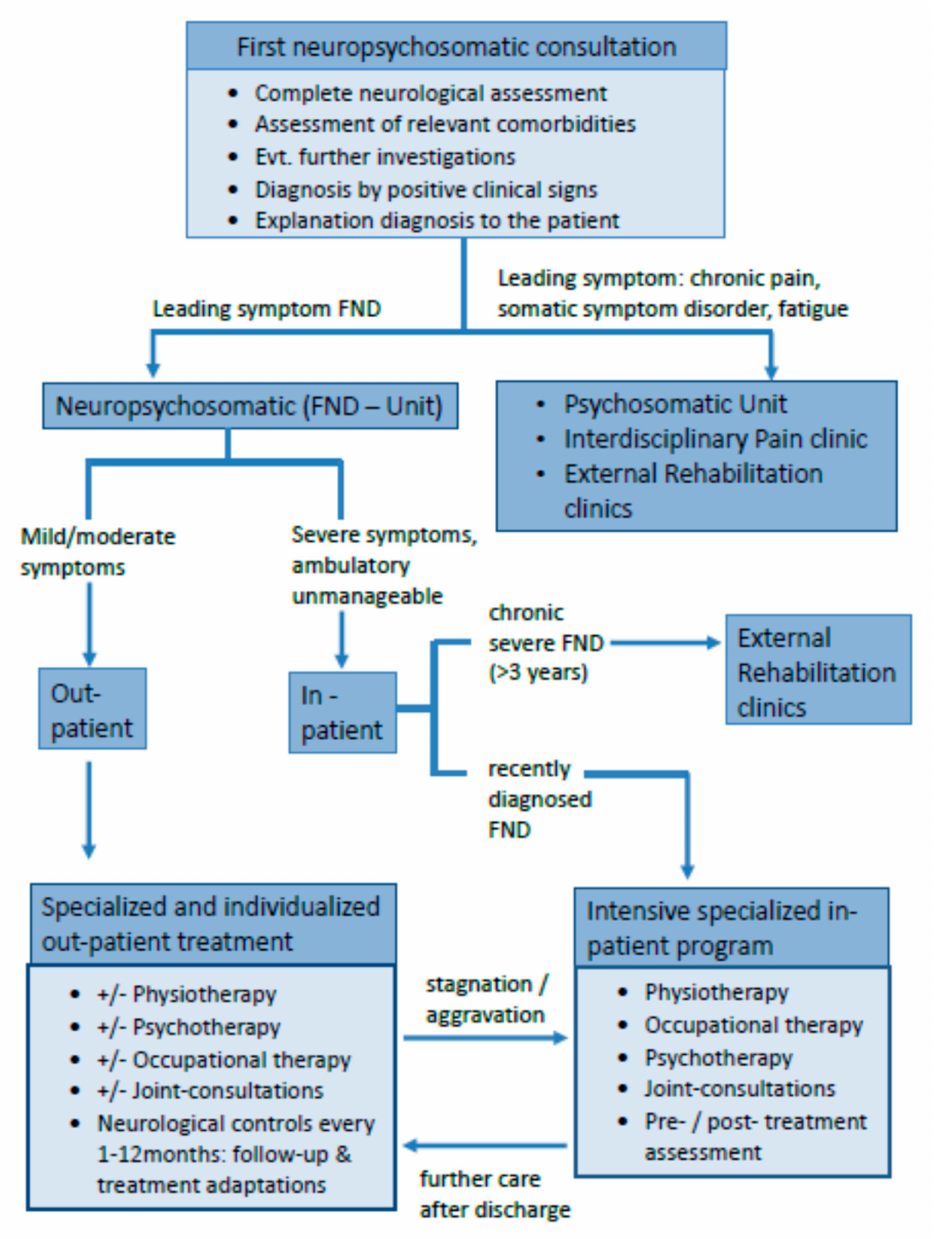
Figure 4. Specialized intern in- and out-patient